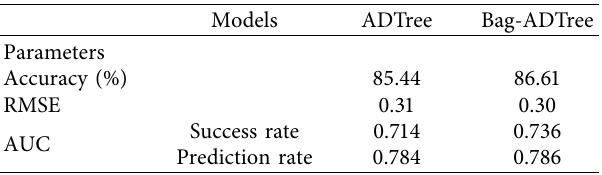
Table 4: Evaluation of the performance of ADTree and bag- ADTree